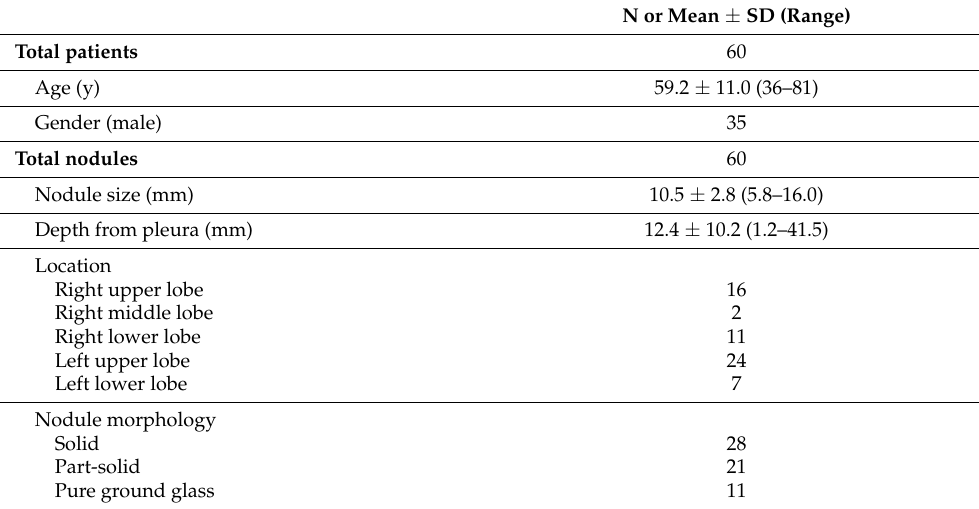
Table 1. Clinical and radiological